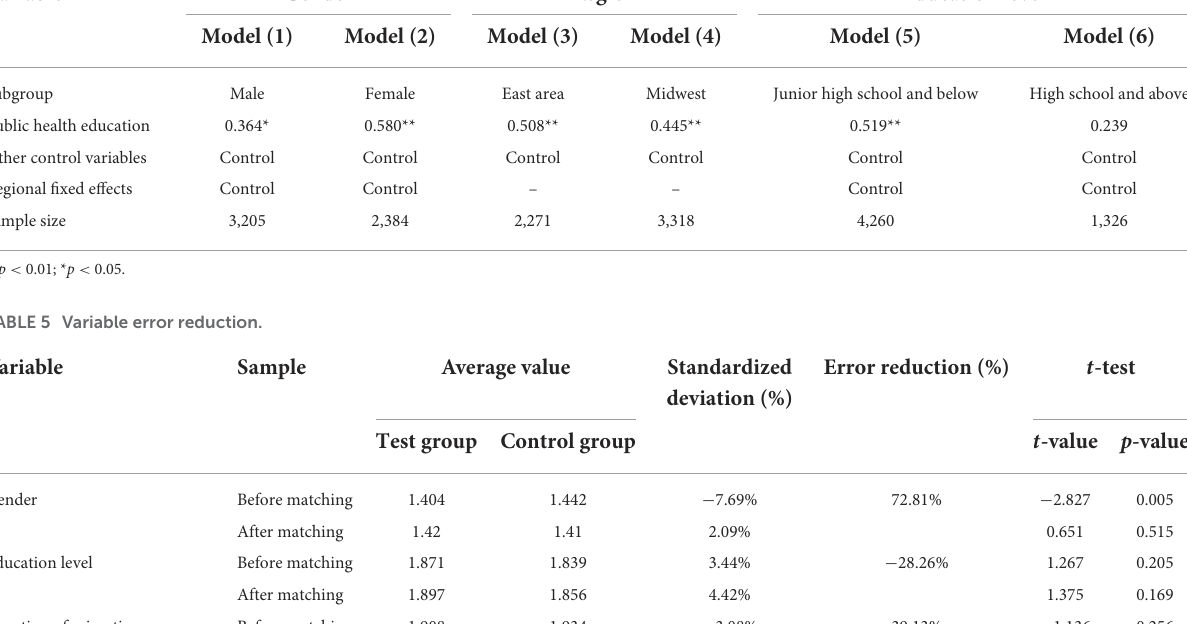
TABLE 4 Heterogeneity test results.